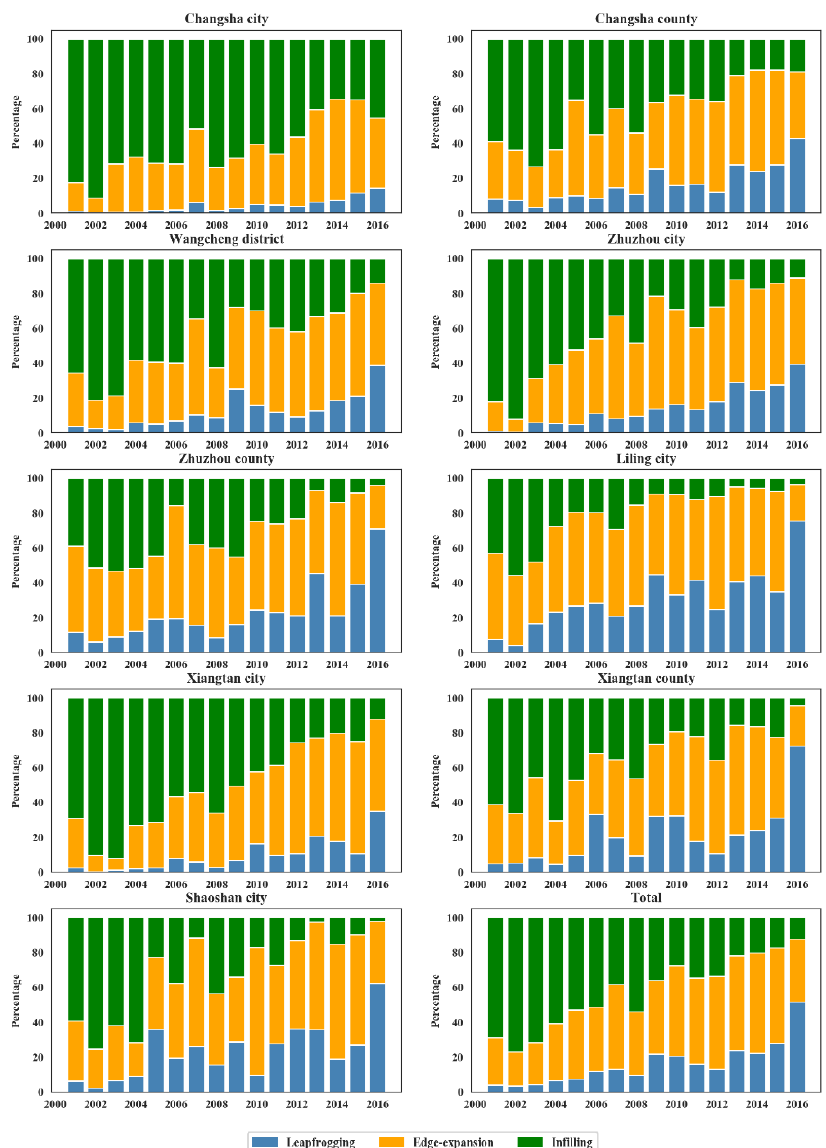
Figure 7. The dynamics of the three urban growth types in terms of the composition (%) of patches of newly developed impervious surface for the nine regions and total region from 2001 to